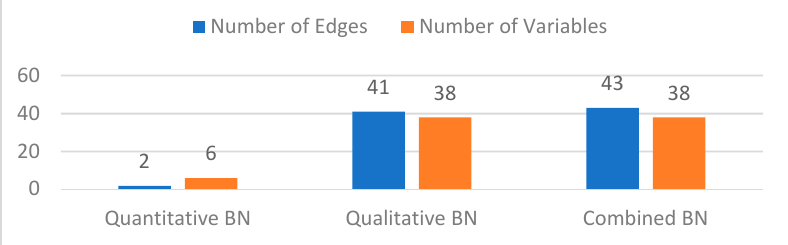
Figure 9. Comparison of the number of variables and arcs of the BN model in Figure 8.